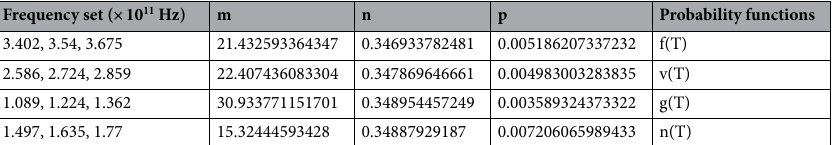
Frequency set (× 10 11 Hz) m n p Probability functions 3.402, 3.54,